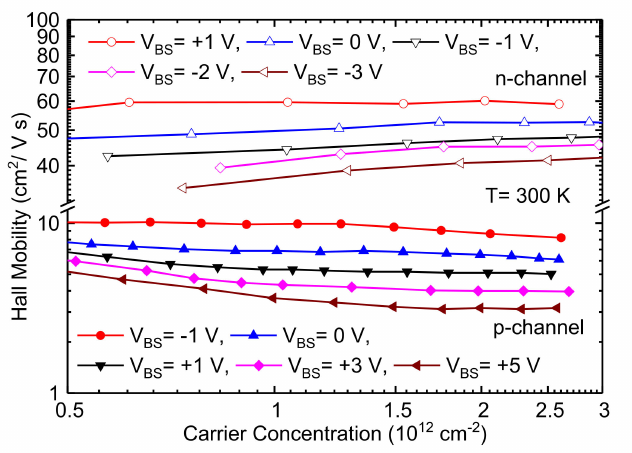
Figure 5. Hall mobility as a function of channel carrier concentration at different body biases at 27 ◦ C. The body bias was varied from +1 to − 3 V for n-channel MOSFETs and − 1 to +5 V for p-channel MOSFETs; the gate bias V GS was swept to modulate the carrier concentrations under a fixed body bias. A forward body bias value decreases the depletion layer width between source and body, increasing mobility, and at reverse body bias, E eff increases due to expansion of depletion layer, which in turn decreases the channel